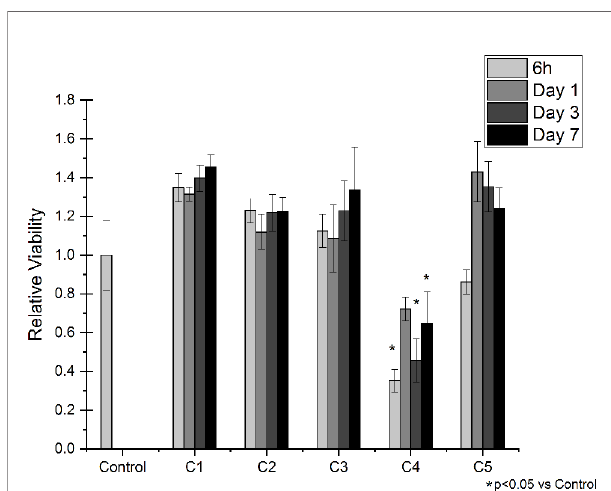
FIGURE 5 | Indirect Viability Assay . Saos-2 cells were treated with conditioned medium collected after 6 hours, 1, 3 and 7 days of incubation with the following conditions: C1, C2, C3, C4 and C5. Normal culture media was used as a control (Control). The graphic shows the relative viability ± SD for each condition.